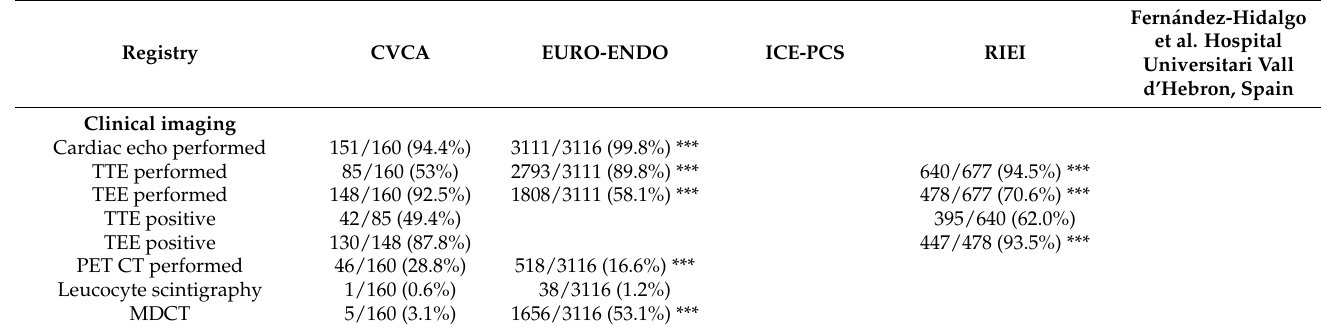
Table A6. Diagnostic Imaging.